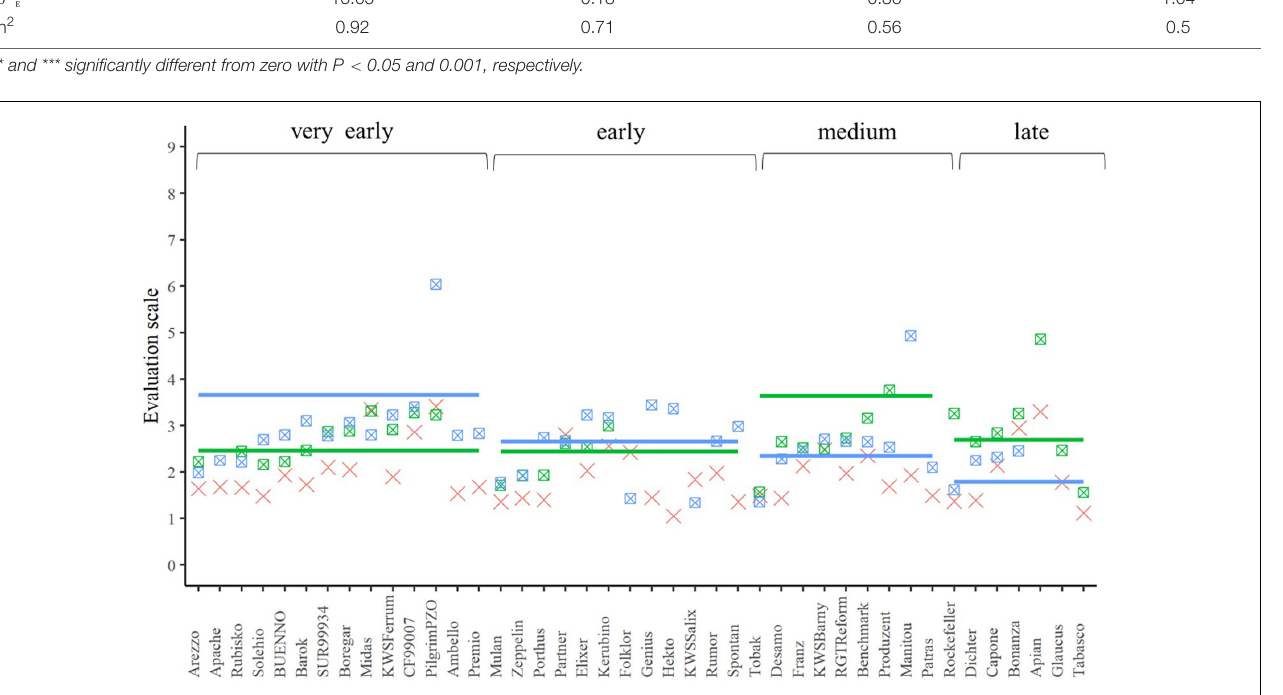
FIGURE 5 | The best linear unbiased estimations of the female (cross), male (line), and their corresponding hybrids (square with cross) for the trait yellow rust resistance. The horizontal bars represent the males in each flowering time group. The males and their offspring have the same